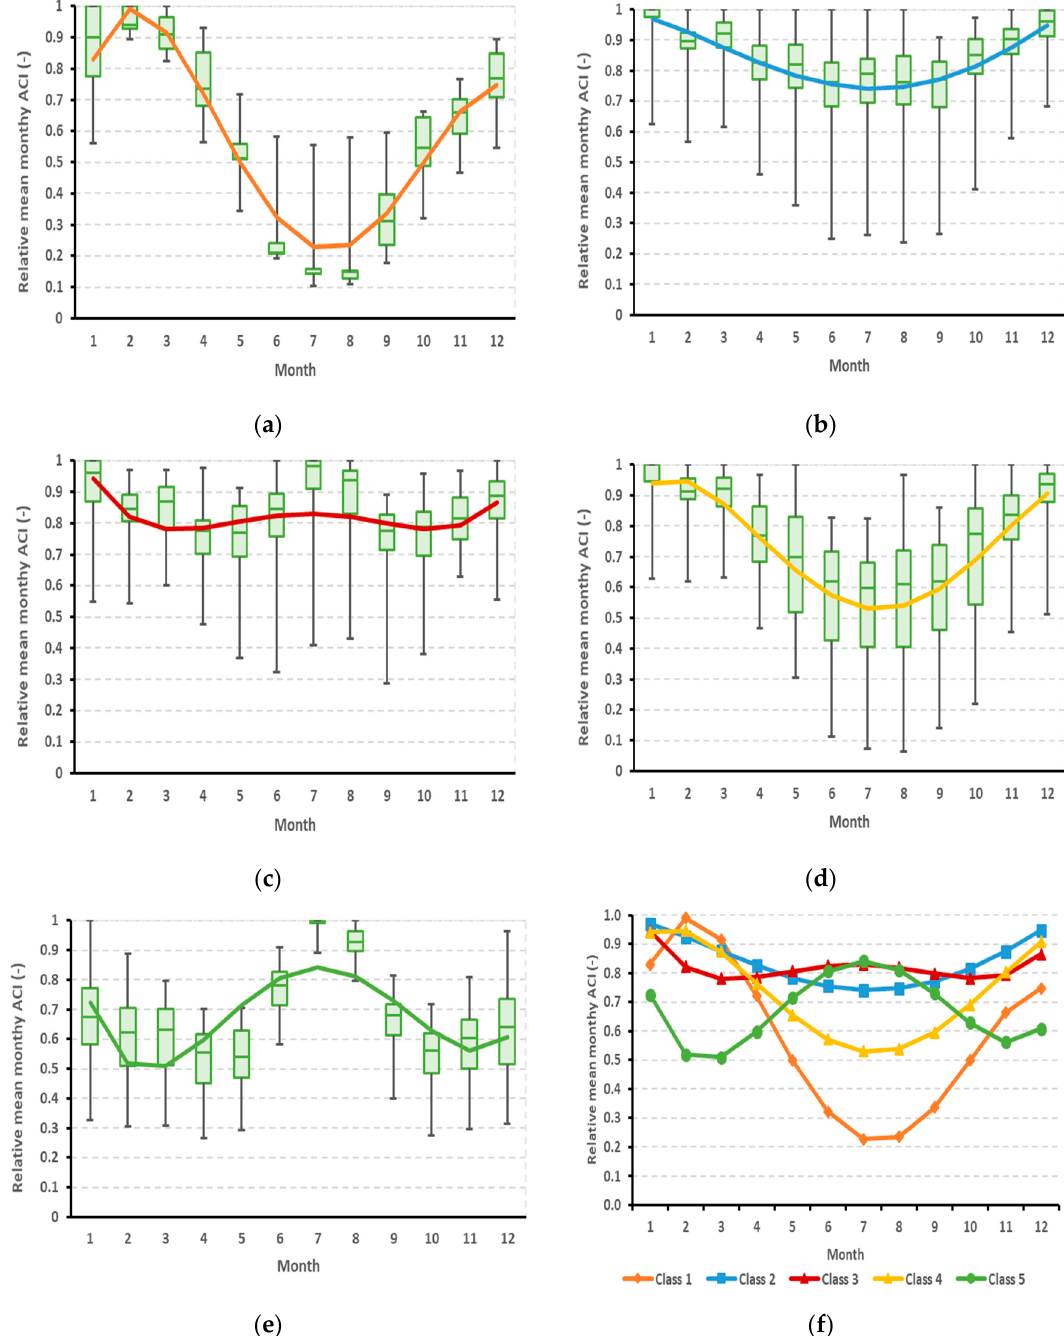
Figure 6. Relative average monthly ACI for the optimal number of clusters: ( a ) class 1, ( b ) class 2, ( c ) class 3, ( d ) class 4, and ( e ) class 5. ( f ) Compares the five classes’ reference values. Apart from some exceptional cases, all samples in each class seem to have low deviations with the reference profile. Thus, the buildings’ characterization appears to be appropriate.